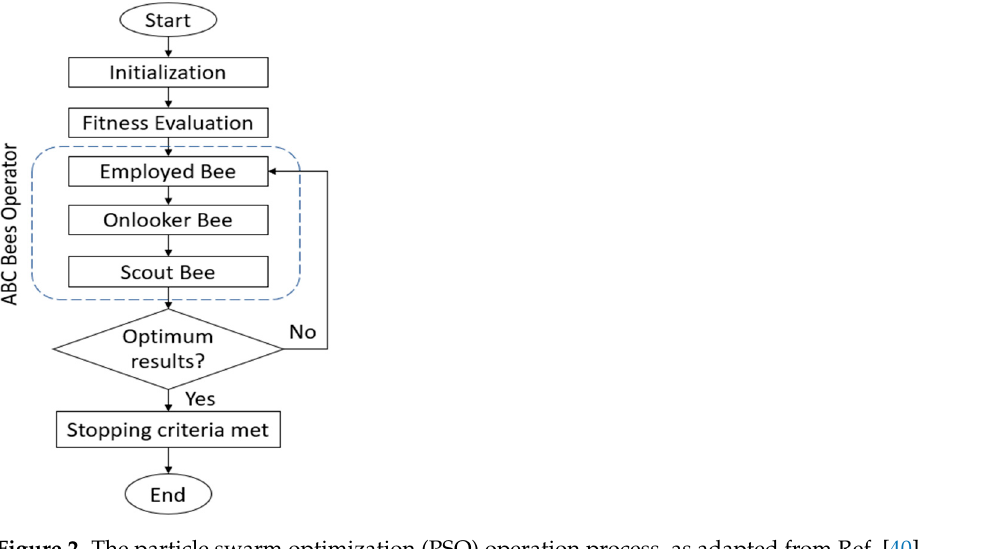
Figure 2. The particle swarm optimization (PSO) operation process, as adapted from Ref. [40].